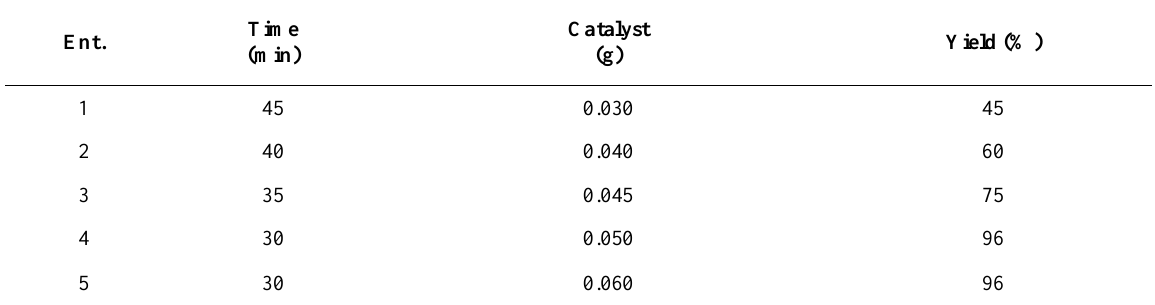
Table 1. Preparation of 4-bromophenyl diazoniumperiodate in the presence of various amounts of nano-SPIA a